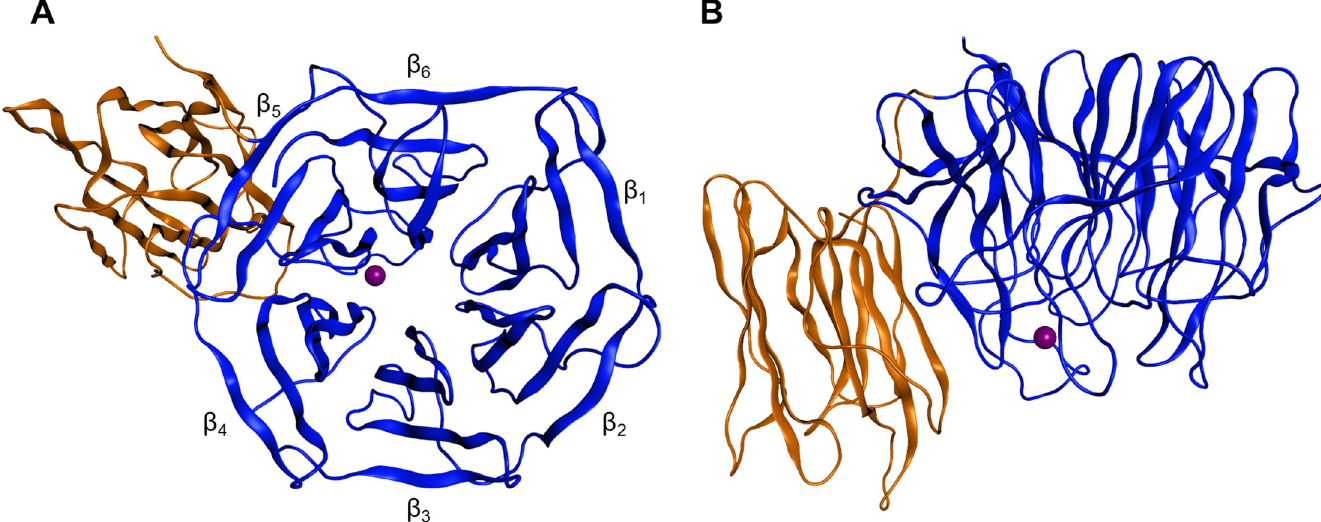
an overall combined energy z-score value of -9.91 indicating a native-like fold of the AtNSP3 model. The evaluation with PROCHECK showed that 99.2% of all dihedrals grouped into most favored and additionally allowed regions of the Ramachandran plot. Only one amino